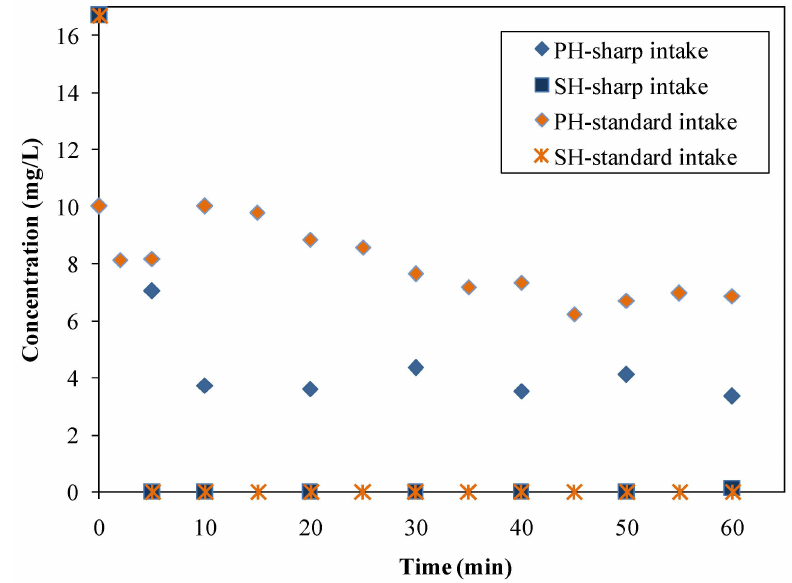
Figure 3. The concentration of model pollutants in the case of individual pollutant removal experiments (PH: phenol; SH: sodium humate; in two examined conditions: (1) standard intake; (2) sharp